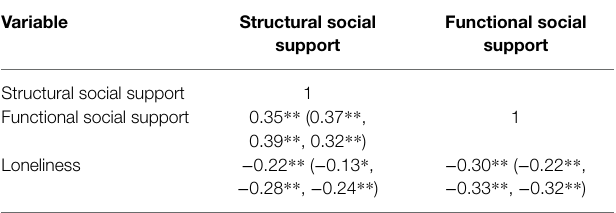
TABLE 3 | Correlations among structural social support, functional social support, and loneliness in older adults by region.